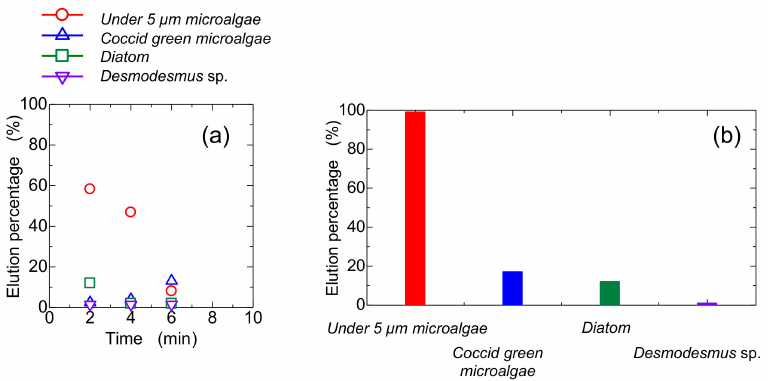
Figure 8. Conventional glass-packed column for elution of microalgae, ( a ) time course curves of each microalgae eluted, and ( b ) total elution